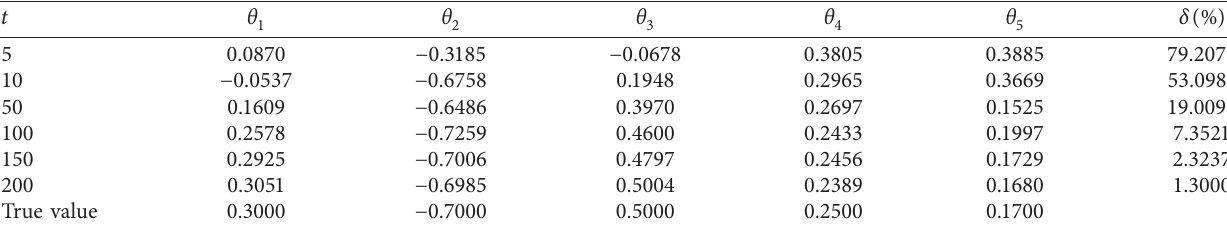
Table 3: The parameter estimates and the estimation errors (MT-SG).